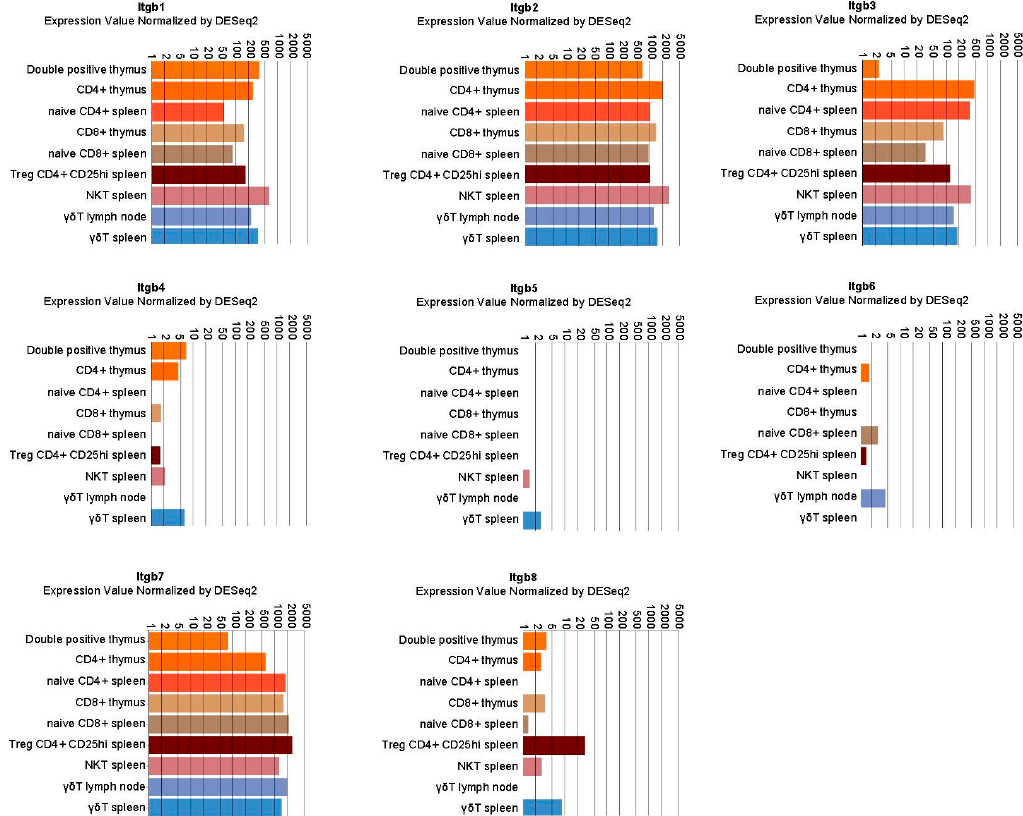
Figure 2. Integrin β chain expression in selected lymphocyte populations. Data were retrieved by the immunological genome project (Immgem ULI RNAseq database, Geo accession: GSE109125) using the RNA-seq Skyline tool and plotted in global scaling (log10) [5].